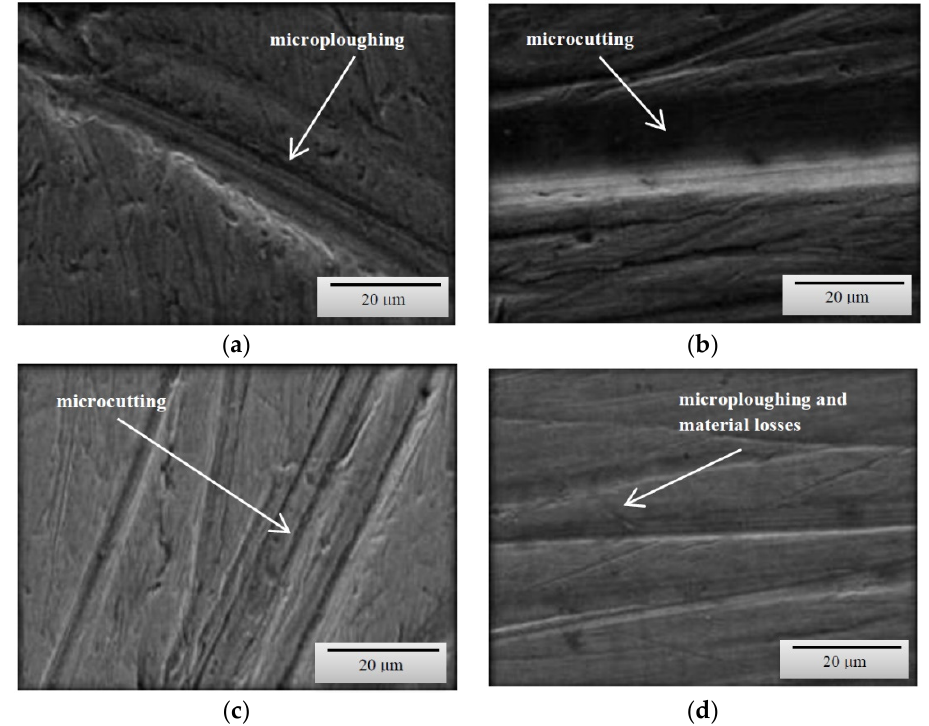
Figure 4. SEM micrographs of the surfaces of tested steels subjected to wear in a medium soil ( a ) B27 steel, magnification 1500×; ( b ) Hardox 500 steel, magnification 1500×; ( c ) XAR 600 steel, magnification 1500×; ( d ) TBL Plus steel, magnification 1500×.